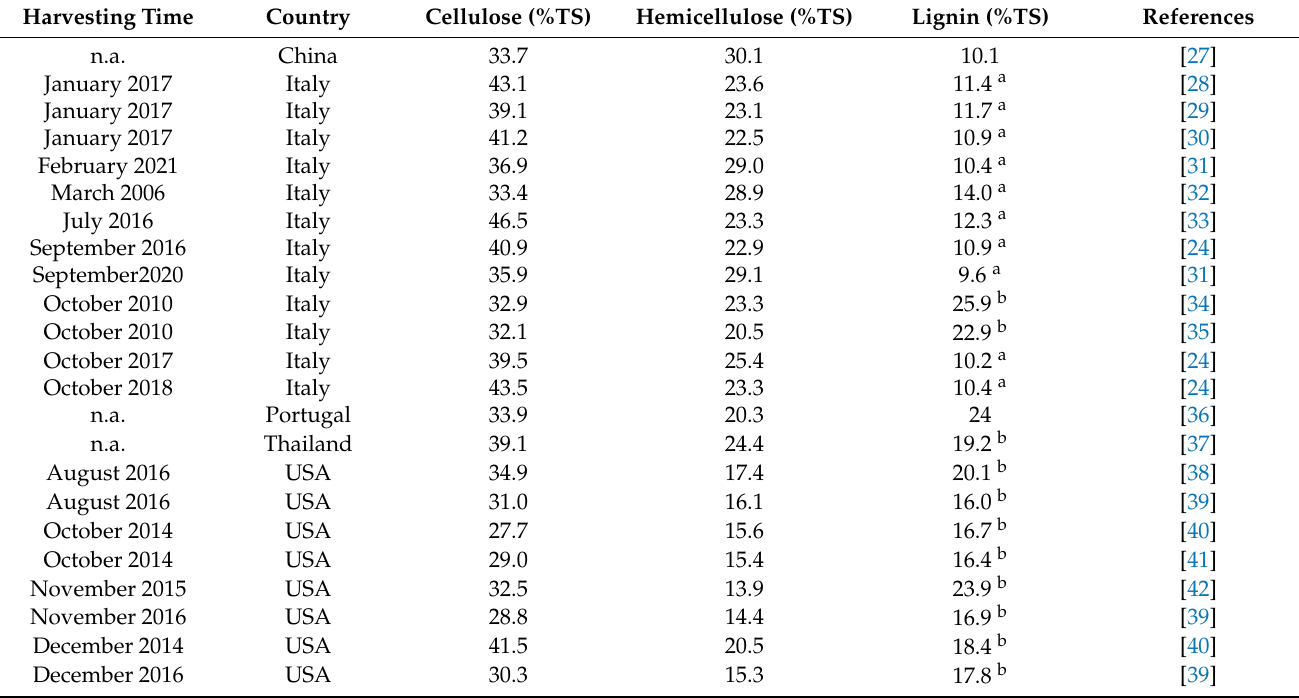
Table 1. Fiber composition of giant reed biomass.